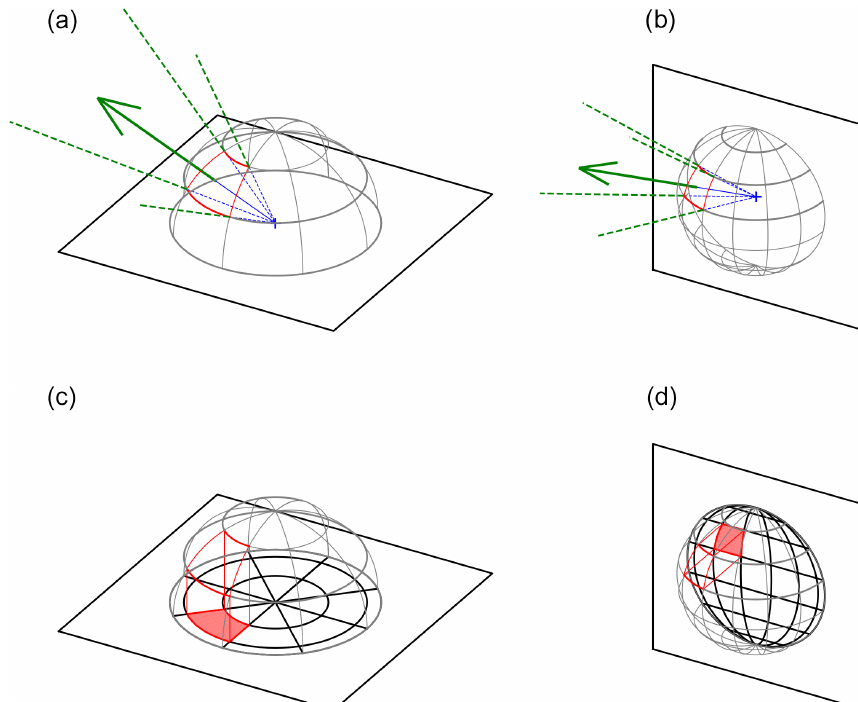
Figure 4. A 3-D representation of the angular discretization scheme for a horizontal face (a, c) and a vertical face (b, d) . The top panels depict a view from the centre of a horizontal and a vertical face; the view has been divided regularly by a fixed number of azimuth and zenith angles, as shown by the half-spheres. The green arrow indicates the traced ray representing the selected angular section, which passes through the centre of that section. The bottom row demonstrates the Nusselt analogue, whereby the area of each angular section’s intersection with the half-sphere, as projected in the orthographic projection to the face’s plane (solid red area), is directly proportional to the corresponding view factor value as a portion of the whole view. From the relative sizes of the projected areas it is clear that the view is less uniformly divided for the vertical faces, yet the unified discretization has computational